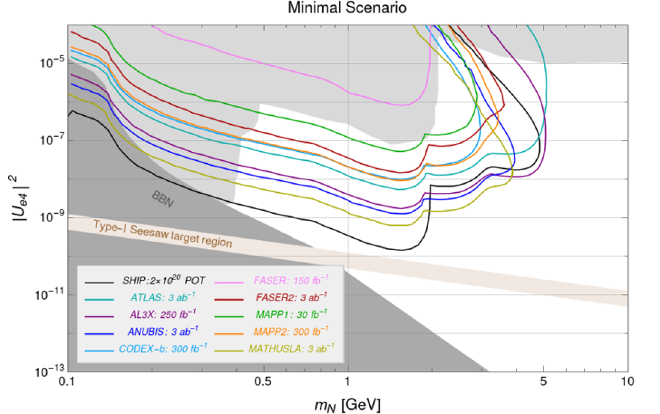
Figure 6 . Results for the minimal scenario with the sterile neutrino mixed solely with the electron